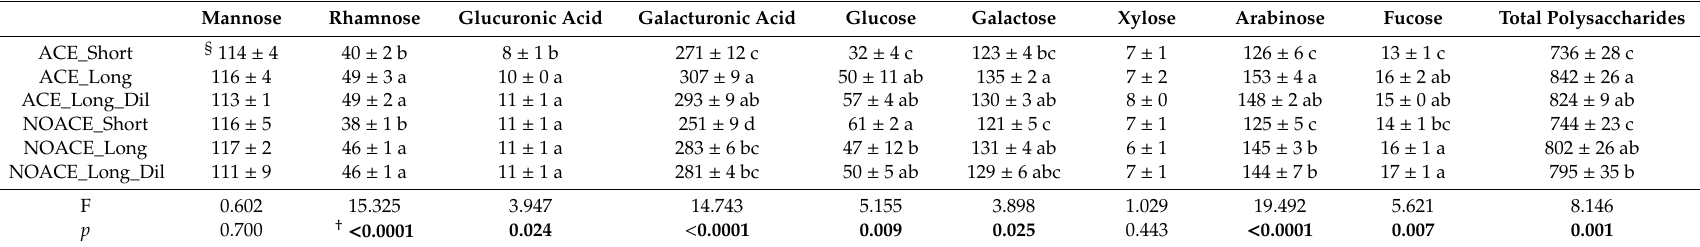
§ Data are the means ( ± standard deviation) of triplicate fermentations, analysed with one-way analysis of variance at an alpha level of 5% and Fisher’s least significant di ff erence test. † Bold p values represent significant di ff erences between the treatments. A post-hoc test was run across the wines within each column; values followed by the same letter in a column are not significantly di ff